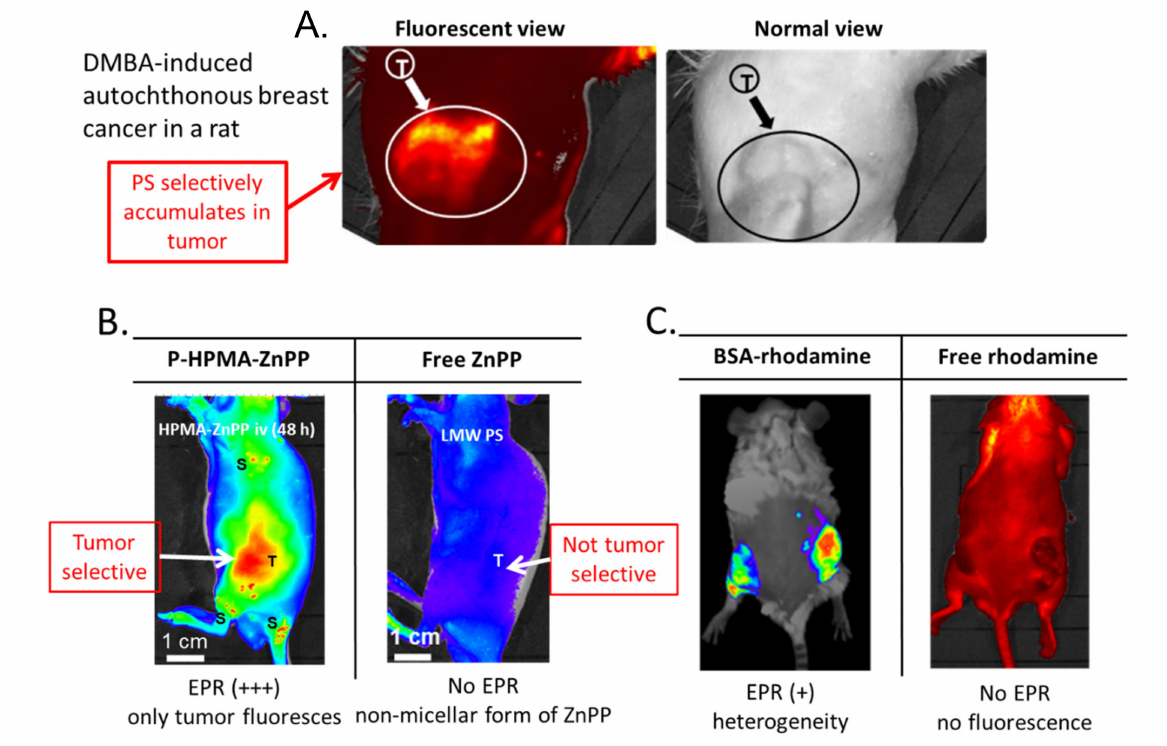
Figure 4. Fluorescence imaging of breast cancer in a rat and of implanted S180 tumor in a mouse, after intravenous injection of P-ZnPP. ( A ) DMBA (7,12-dimethylbenz[ a ]anthracene)-induced breast cancer in a rat. Under fluorescent light (left) and under normal light (right). ( B ) Fluorescent image of nano-PSs: polymeric HPMA-ZnPP (P-HPMA-ZnPP) and free ZnPP. ( C ) Rhodamine-conjugated bovine albumin (BSA) vs. free rhodamine. Images show no accumulation of LMW free PSs in tumors ( B , C ). ( A , adapted from [58]; B , C , adapted from ref.